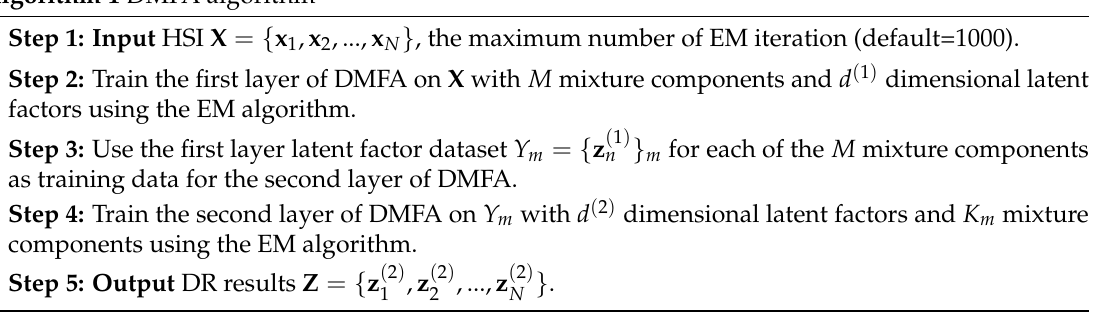
Figure 3. The schematic of the DMFA corresponding to Figure 1 c . Algorithm 1 DMFA